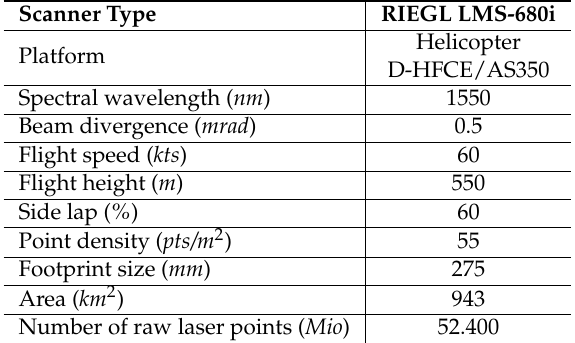
Table 1. Flight parameters of lidar campaign.